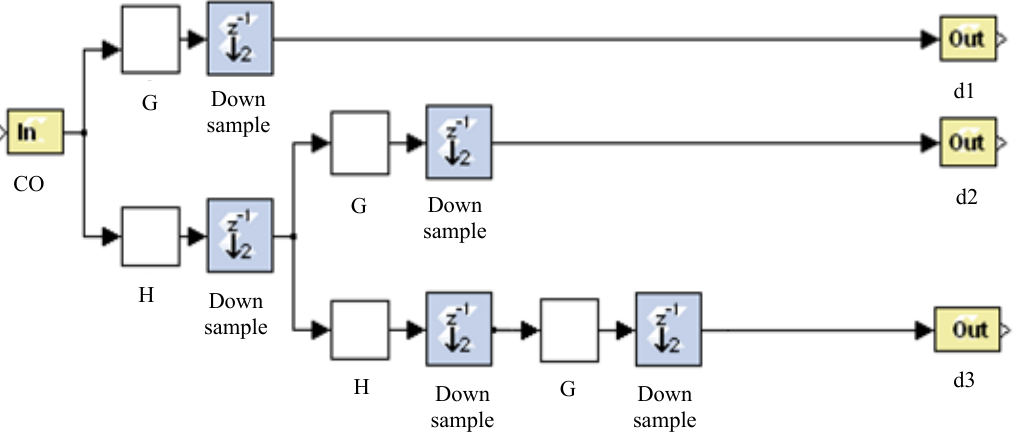
, d and d in Xilinx System Generator 1 2 3